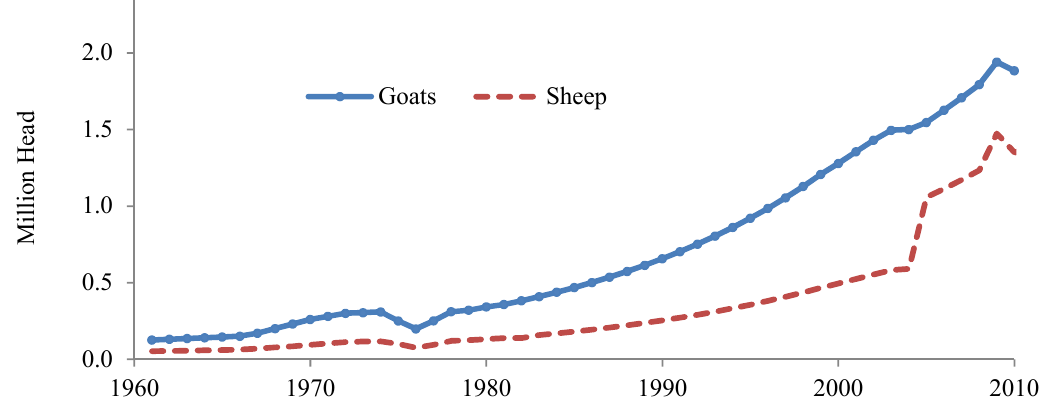
Figure 1. Number of sheep and goat stock in the United Arab Emirates 1960–2010.